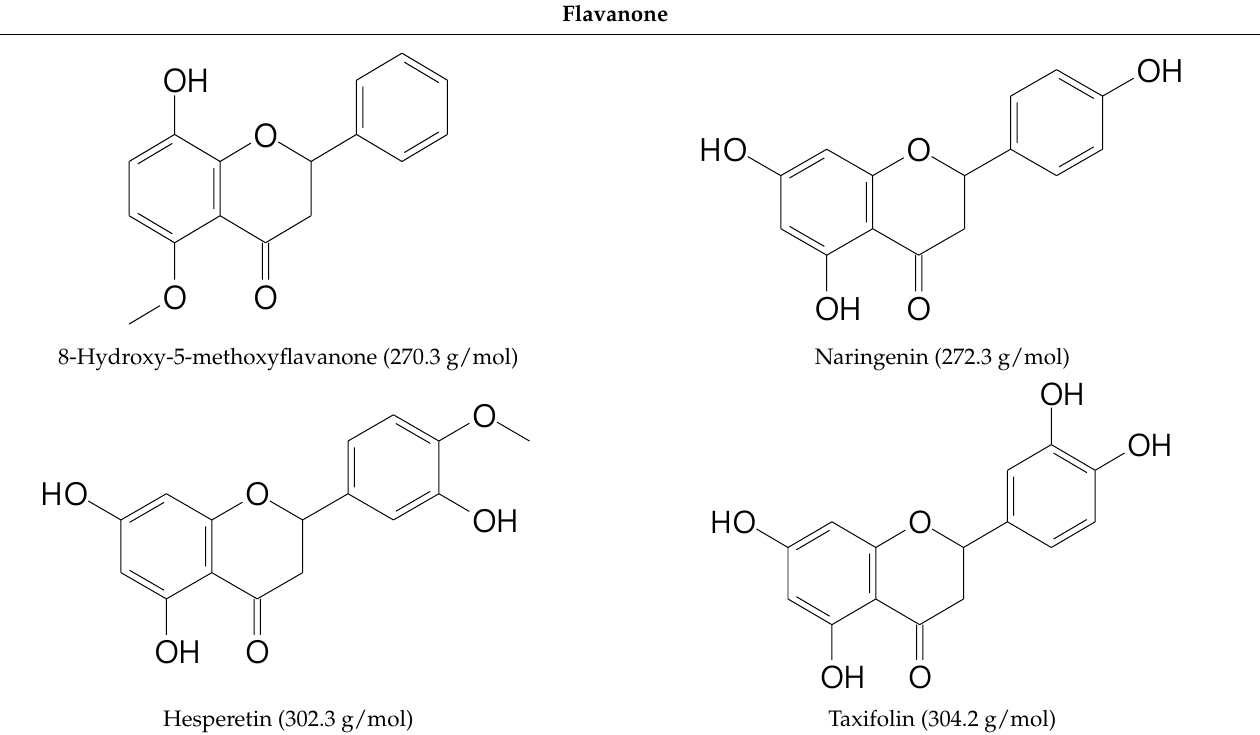
Table 2. Basic structures of some flavonoid classes verified in selected studies. Flavanone